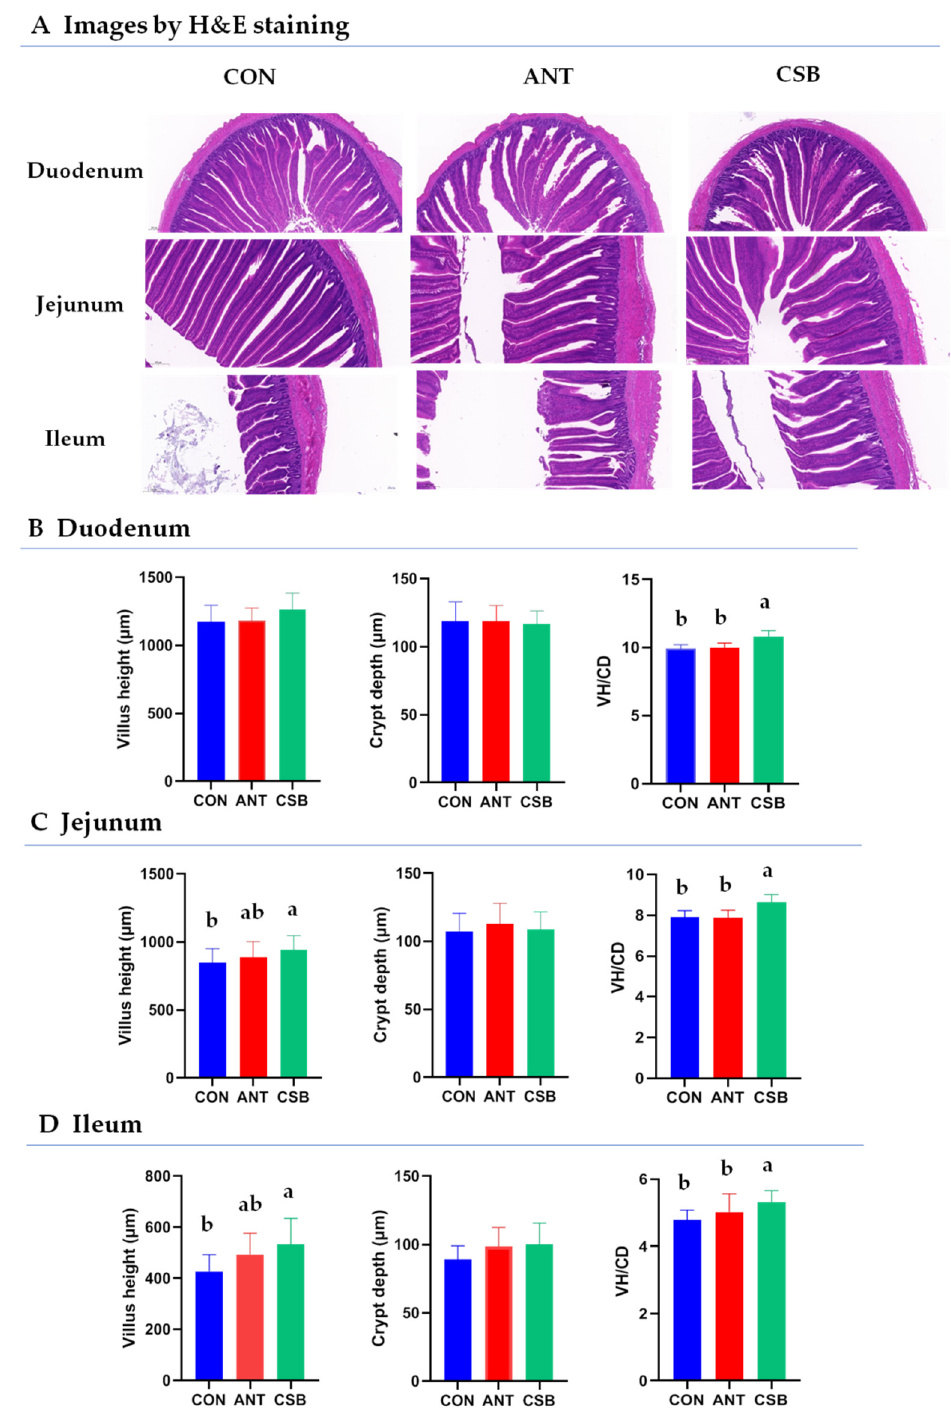
Figure 1. Effects of CSB on the morphology of the small intestine in broilers at 21 d of age. VH/CD: the ratio of villus height to crypt depth. Treatments: CON, the control diet; ANT, CON diet supplemented with antibiotics (enramycin, 8 mg/kg and aureomycin, 100 mg/kg); CSB, CON diet supplemented with 1000 mg/kg CSB; the same the following. Values are expressed as the mean ± SE, n = 8, the same the following. a,b: mean values were significant difference in the bars labeled with different letters ( p < 0.05).